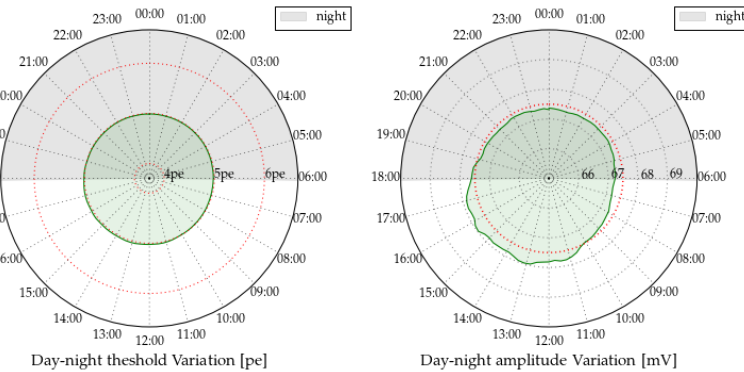
Figure 14. Photo-electron ( left ) and pulse amplitude ( right ) variation of the MuTe-SiPM with temper- ature values at the Cerro Machín